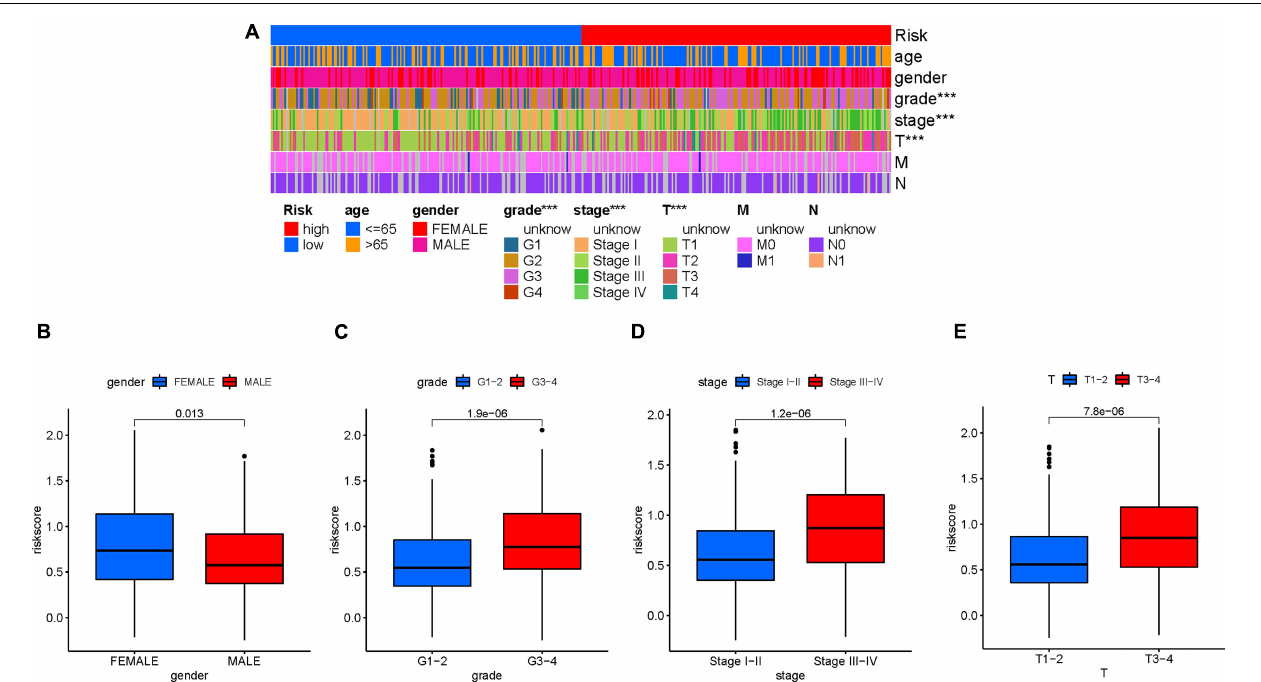
FIGURE 5 | Clinical significance of the prognostic risk signature. (A) Heatmap presents the distribution of clinical feature and corresponding risk score in each sample. Comparison of risk score among different subgroups classified by clinical characteristics: gender (B) , tumor grade (C) , clinical staging (D) , and T status (E) . The asterisks represented the statistical p value ( ∗∗∗ P <